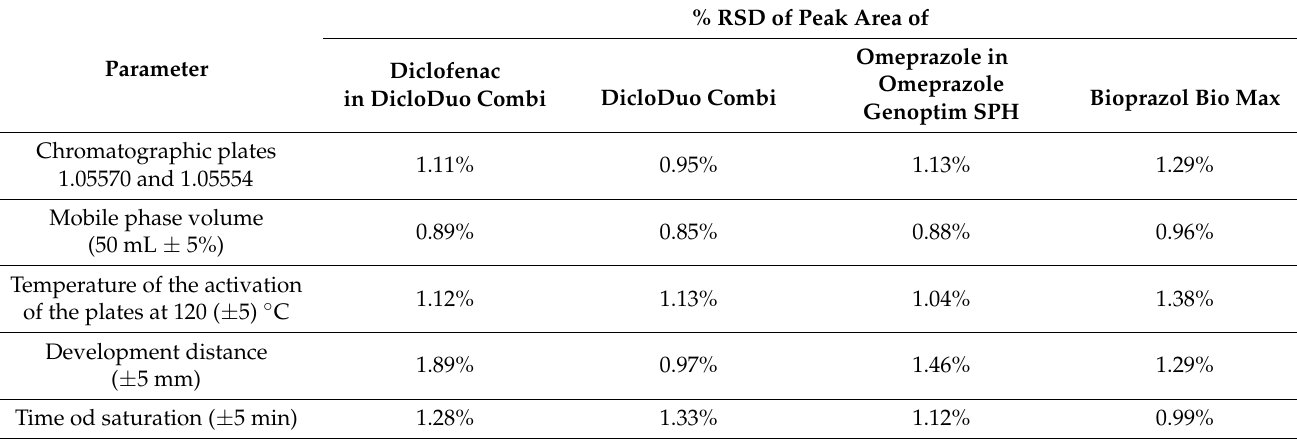
Table 6. Robustness of the proposed methods ( n =